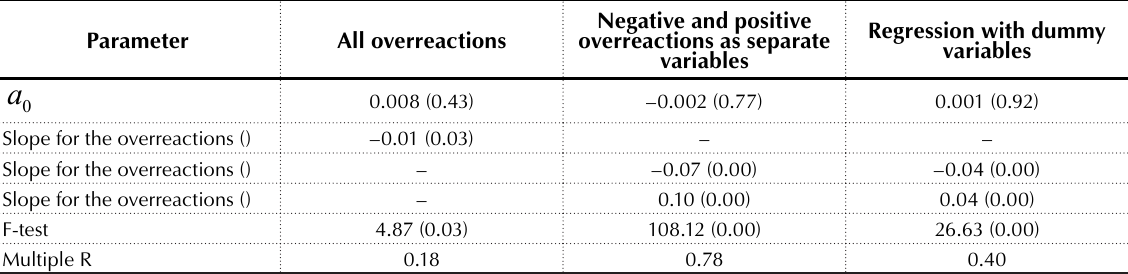
Table 6. Regression analysis results: case of PFST index log returns as a dependent variable Parameter